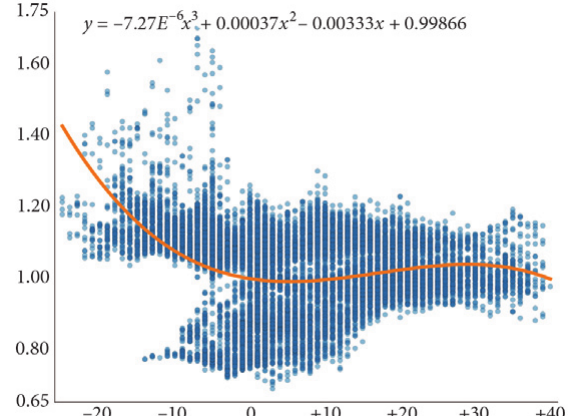
Fig. 1. Adjustment coefficients and describing function for A1 data